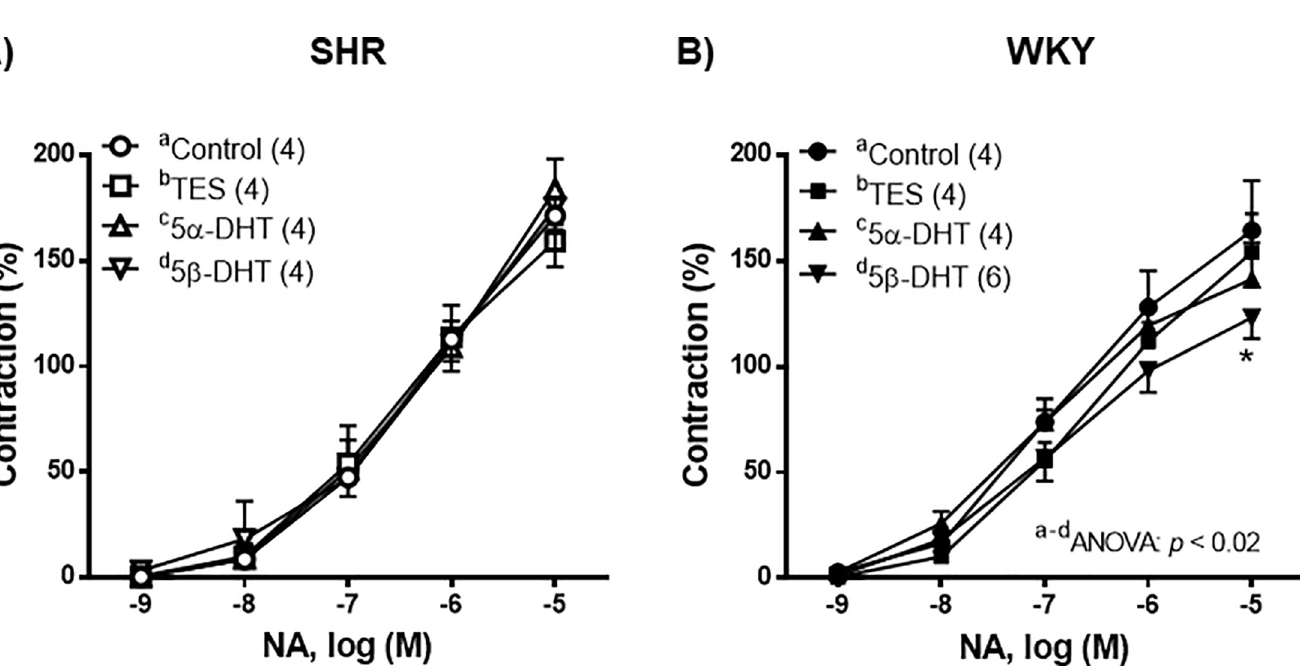
PLOS ONE | https://doi.org/10.1371/journal.pone.0246254 February 2,